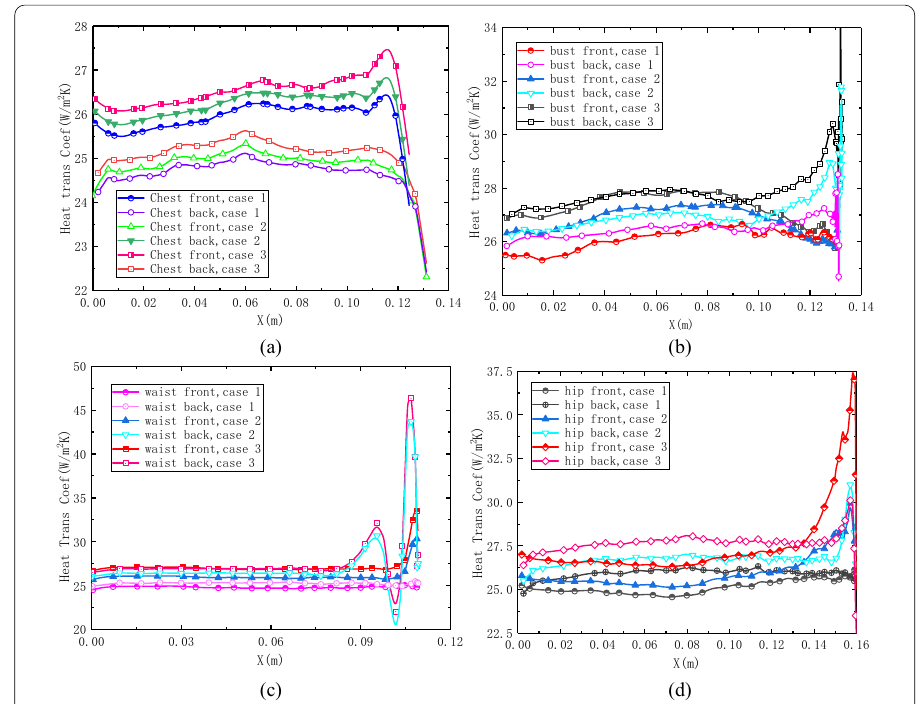
Fig. 8 Heat transfer coefficient distribution on body surface. a Chest girth, b bust girth, c waist girth, d hip girth